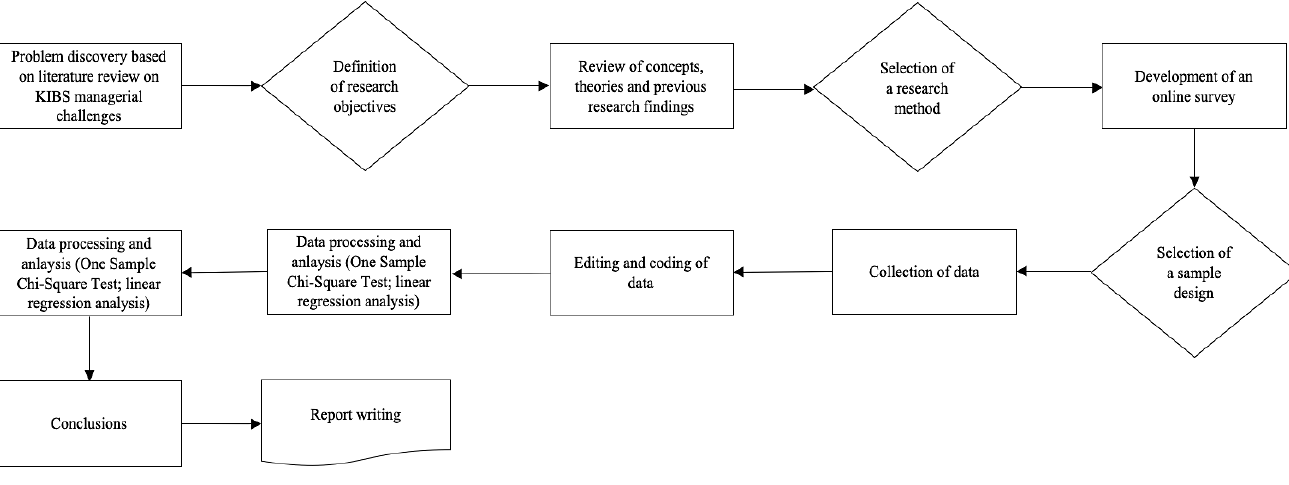
Figure 1. Flowchart of the research